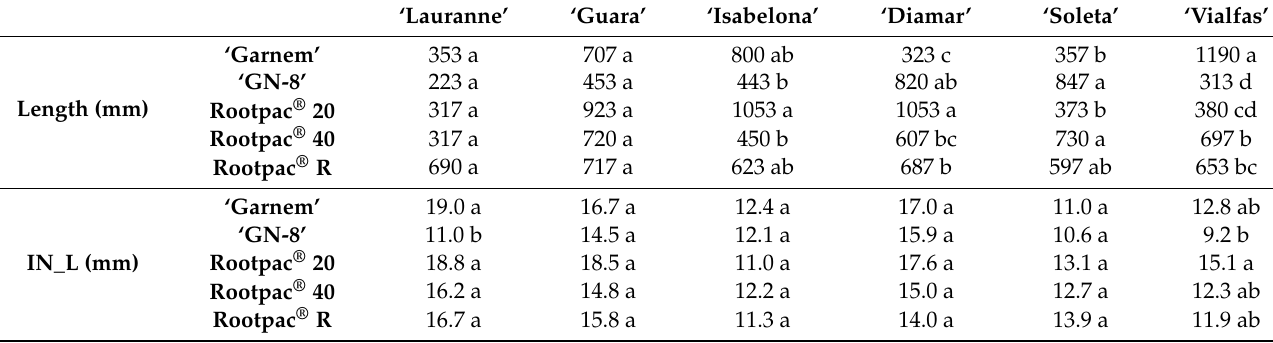
Table 4. Analysis of the 7 non-redundant variables in the 30 rootstock/scion combinations, comparing by rootstock choice. Data were collected from 2-year-old trees. Refer to Table 1 for